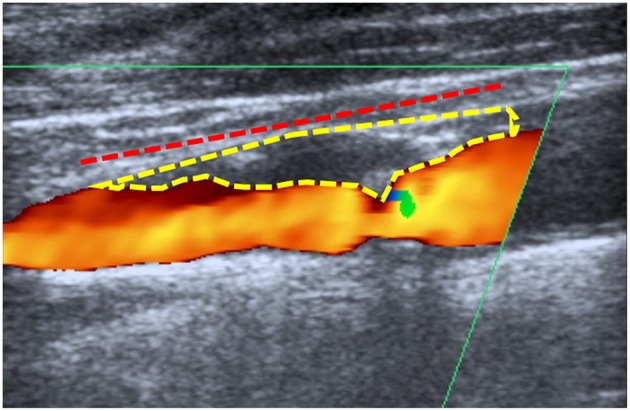
Measurement method: Example for the method used to measure the plaque length (dashed red line) and cross-sectional area (dashed yellow) in a patient with symptomatic low-grade internal carotid artery stenosis of 20–40%.